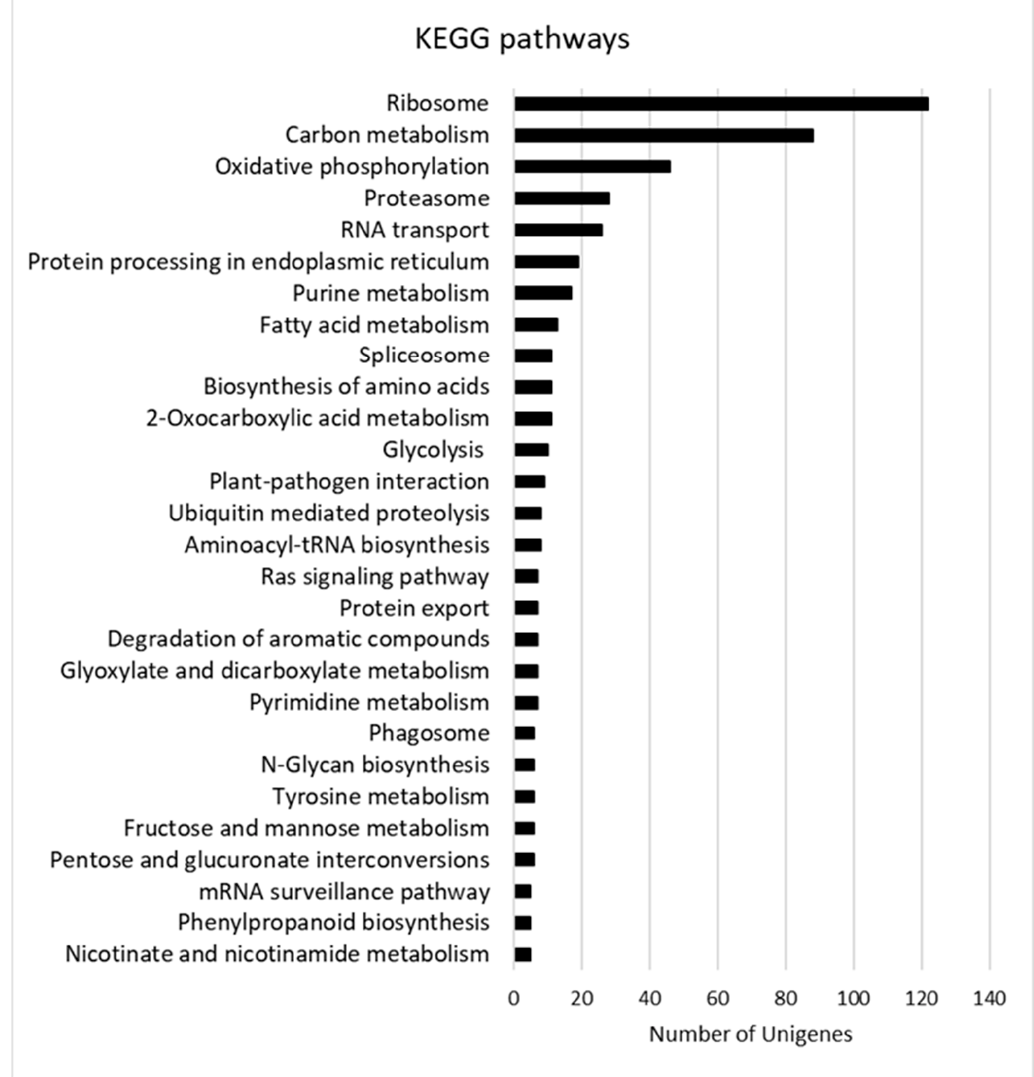
Figure 3. Most represented KEGG pathways. Pathways with at least five Unigenes are listed.